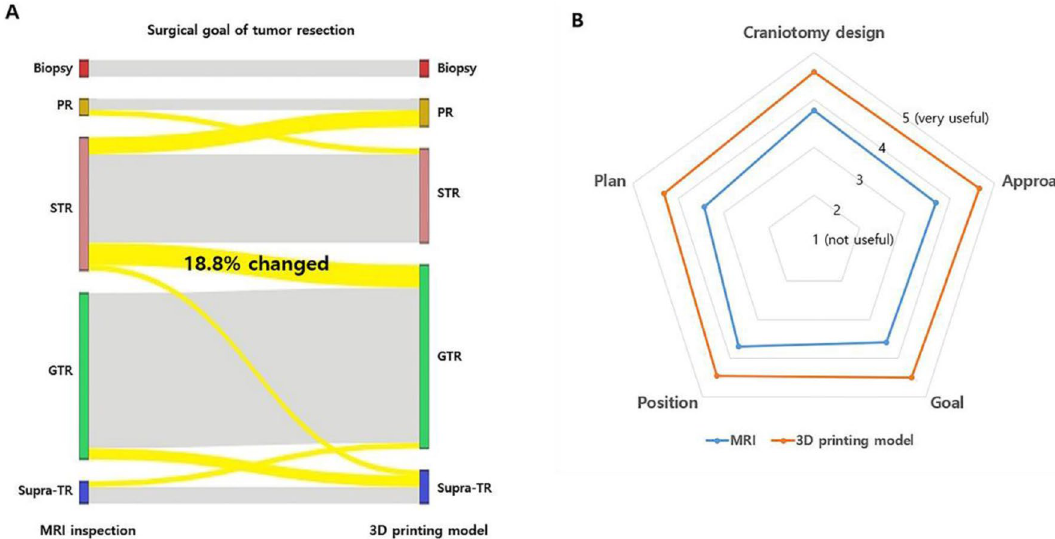
Figure 4. ( A ) Sankey diagram showing the change in the extent of tumor removal between the MRI-based and 3D-printed brain tumor model-based plans. Overall, for 12 out of 64 cases (18.8%), the surgical goal was modified after examining the 3D-printed brain tumor model. (PR, partial resection; STR, subtotal resection; GTR, gross total resection; Supra-TR, supra-total resection). ( B ) The result of the questions evaluating the usefulness of MR images and the 3D-printed model in establishing surgical plans, as scored on a 5-point scale from 1 (not useful) to 5 (very useful). In all questions, the 3D-printed brain tumor model scored higher than the MR images.